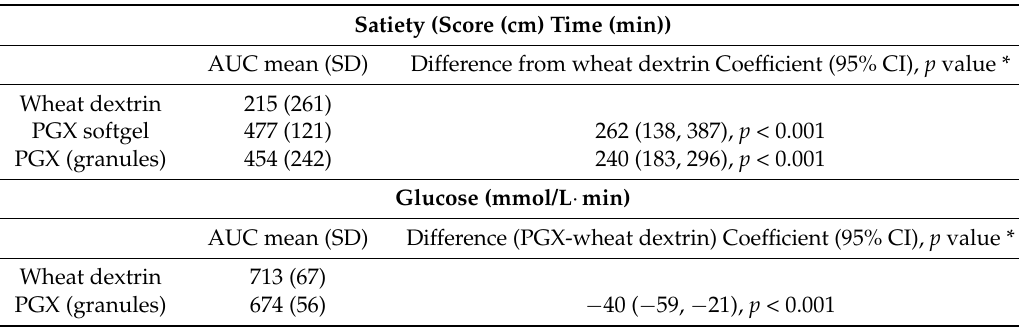
Table 2. Area under curve (AUC) for postprandial satiety and blood glucose levels.